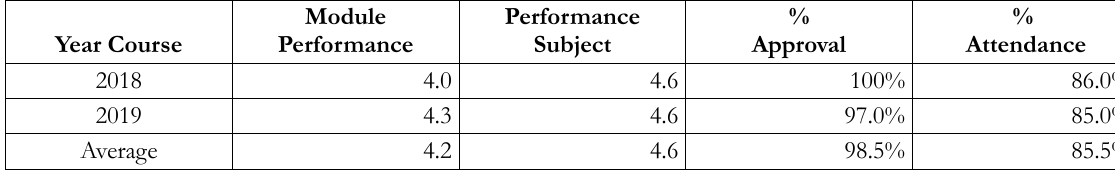
Table 1. History of assessment averages, approval, and